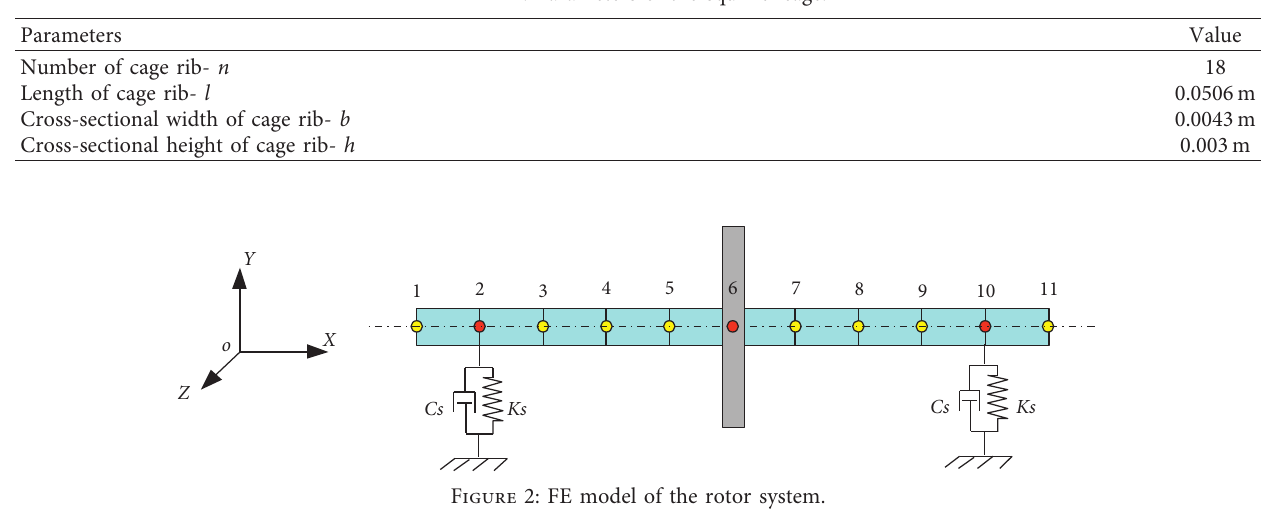
Table 2: Parameters of the squirrel cage.